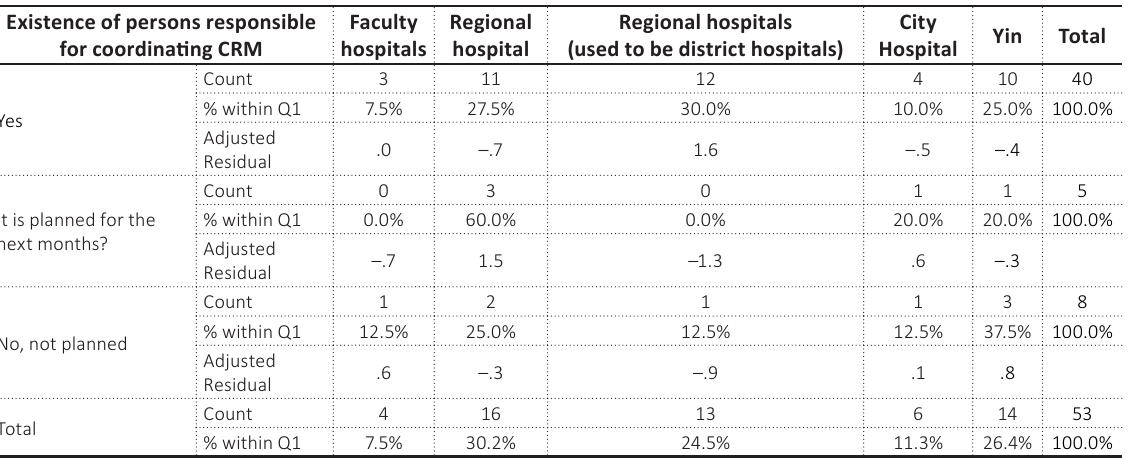
Table 1. Existence of persons responsible for coordinating clinical risk management activities relative to hospital type